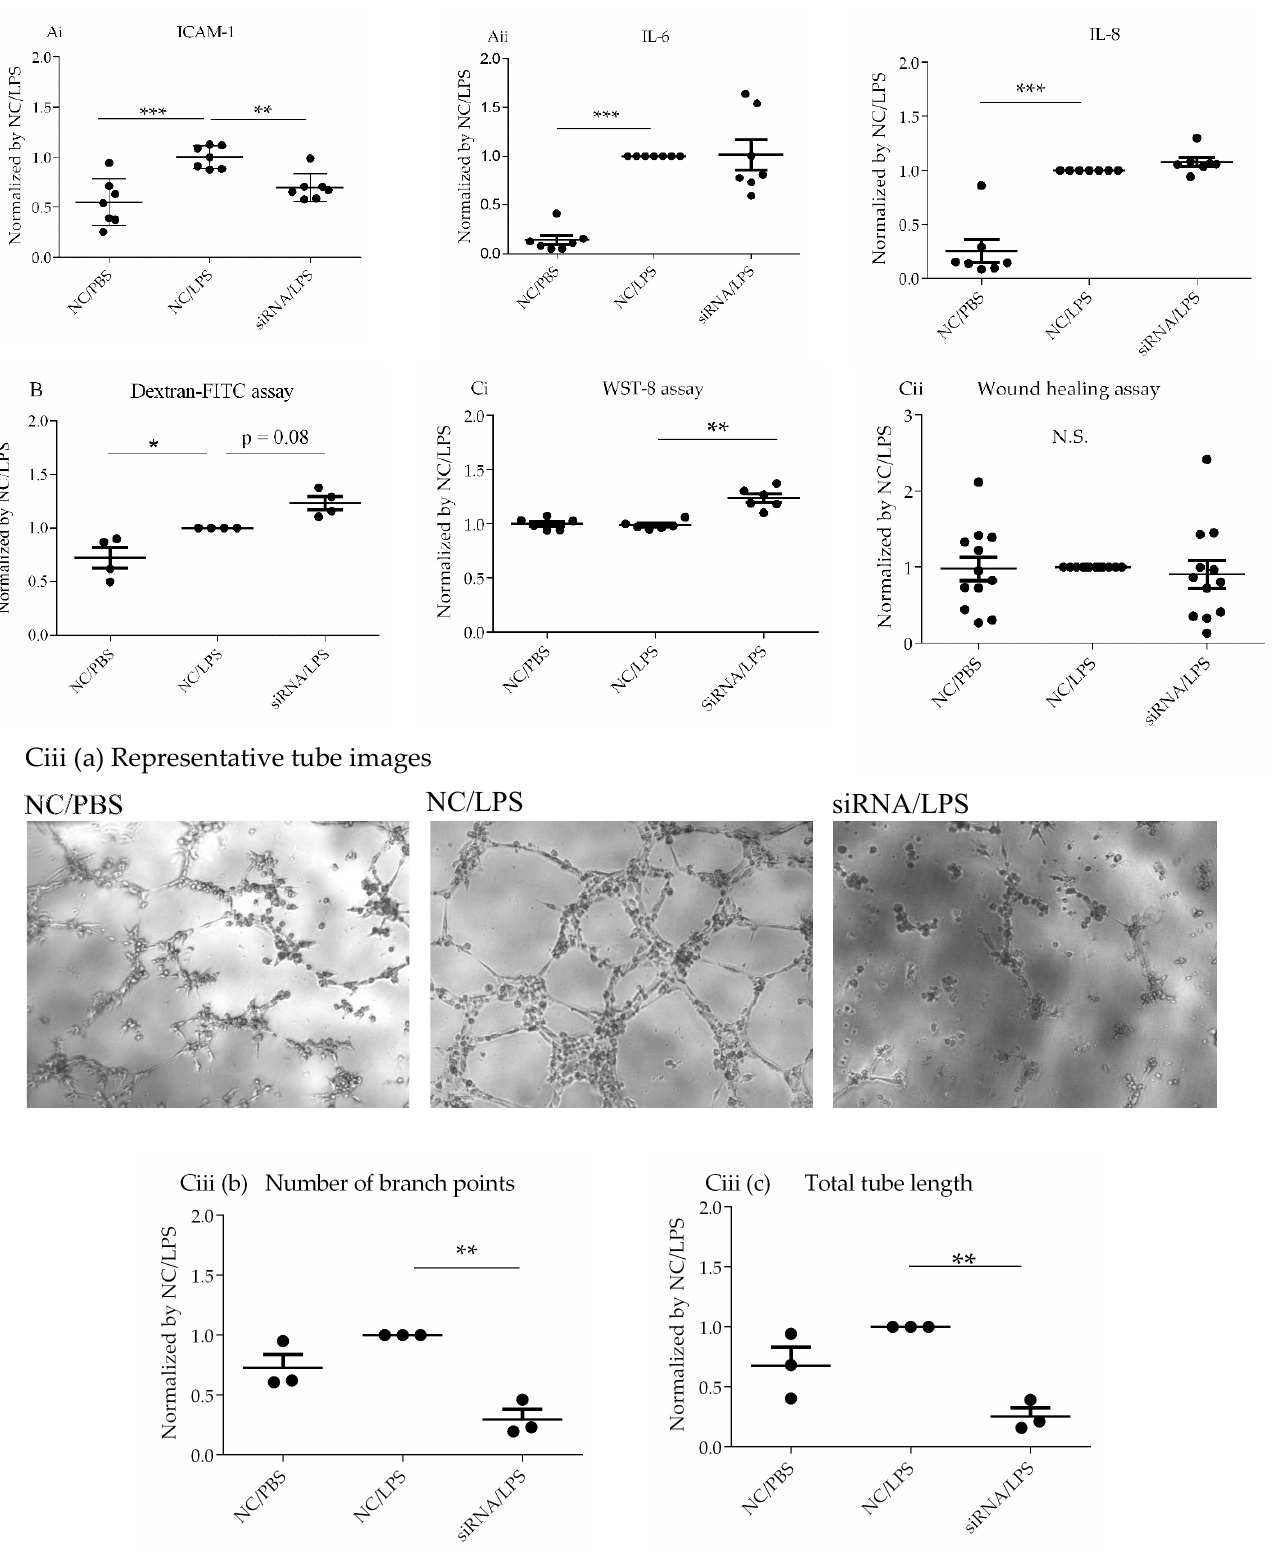
Figure 5. Confirmation studies of HLMVECs after LPS challenge. ( A ) Assessment of pro-inflammatory parameters. ( i ) ICAM-1 expression levels on HLMVECs. HLMVECs were transfected with non-specific or DPP4 -specific siRNA for 72 h, and then challenged with LPS (1 µ g/mL) or PBS for 18 h. ICAM-1 expression on HLMVECs was measured by mean fluorescence intensity (MFI) using flow cytometry analysis. ( ii ) Release of pro-inflammatory cytokines IL-6 and IL-8. HLMVECs were transfected with non-specific or DPP4 -specific siRNA for 72 h, and then challenged with LPS (1 μ g/mL) or PBS for 6 h. Secreted cytokine levels in the conditioned media were measured by ELISA, and the values were normal- ized to that of non-specific siRNA/LPS-treated groups. Levels of both IL-6 and IL-8 were increased by LPS challenge, but no differences were observed between the groups treated with non-specific RNA and DPP4 siRNA. * p < 0.05, ** p < 0.01, *** p < 0.001. Values are means ± SD of three or more independent experiments. N.S., Not significant; NC, Non-specific control; siRNA, DPP4 siRNA. ( B ) Assessment of monolayer permeability in HLMVECs. Permeability was evaluated by dextran-FITC assay. LPS enhanced monolayer permeability of the HLMVECs. DPP4 siRNA further increased HLMVEC permeability after LPS stimulation. ( C ) Assessment of regenerative process in HLMVECs after LPS. ( i ) WST-8 assay to evaluate proliferative capacity of HLMVECs. HLMVECs were transfected with non-specific, or DPP4 -specific siRNA for 72 h, and then challenged with LPS (1 μ g/mL) or PBS for 18 h. Proliferation was assessed using a WST-8 assay. ( ii ) Wound healing assay to migratory ability of HLMVECs. HLMVECs were transfected with non-specific, or DPP4 -